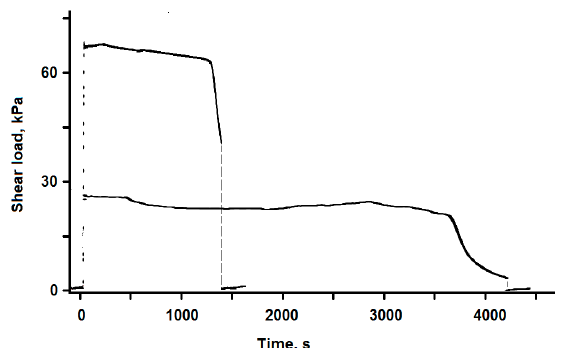
Figure 7. Dependence of shear stress measured by the loading force sensor on the time elapsed after the load is applied along the axis of an aluminum cylinder with a superhydrophobic surface, one of the ends of which is frozen in the ice at − 8 °C. Two dependences corresponding to different values of the initial load are presented [4].